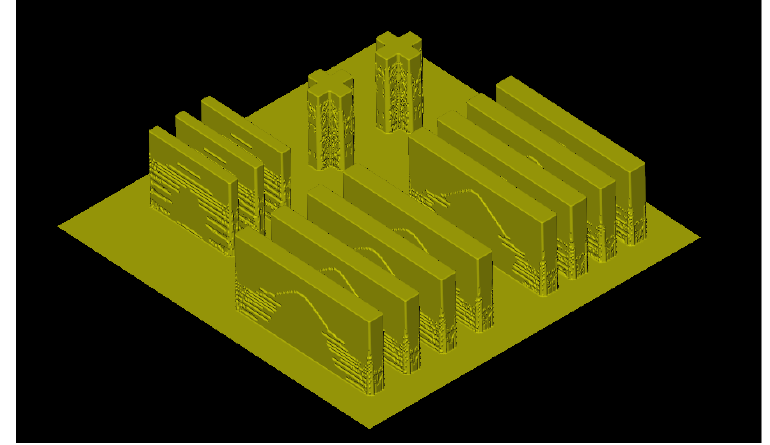
Figure 11. 3D simulation results of UV lithography for 240 ± 12 μ m thick SU-8 with a complex mask